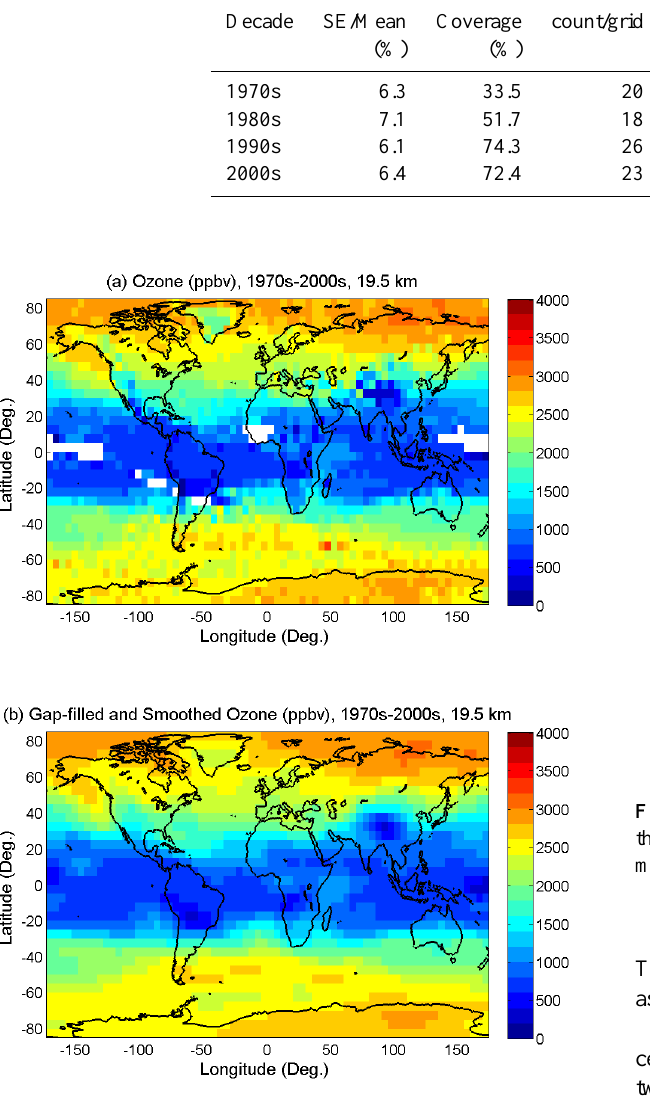
Fig. 11. (a) Long-term ozone climatology (1970s-2000s) at 19.5 km with gaps (white areas). (b) The gaps are filled and the ozone field is smoothed by a spherical function-based interpolation.